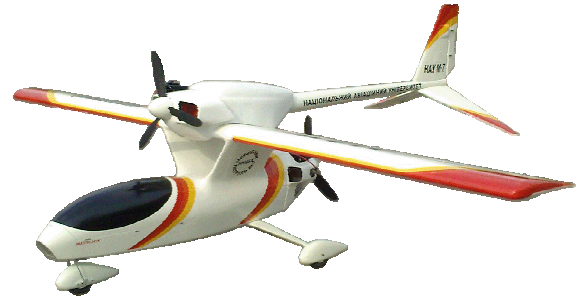
Fig. 2. General view of the left side of the special purpose UAV developed by the NAU